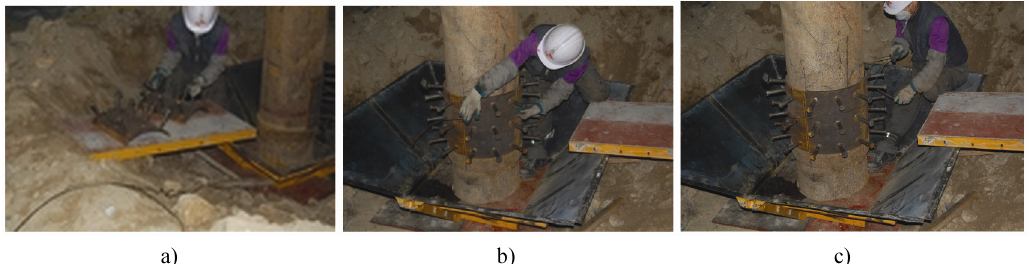
Fig. 10. Installation procedure for the shear connection system: (a), (b) placing of shear jackets on the bearing shear band, and (c) shear jacket connections